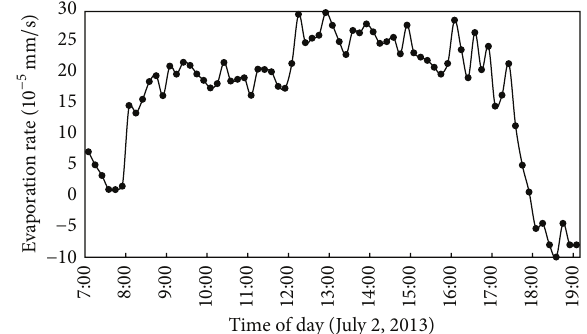
Figure 7: Diurnal variations of the water temperature at the upstream and downstream ends (July 2, 2013).